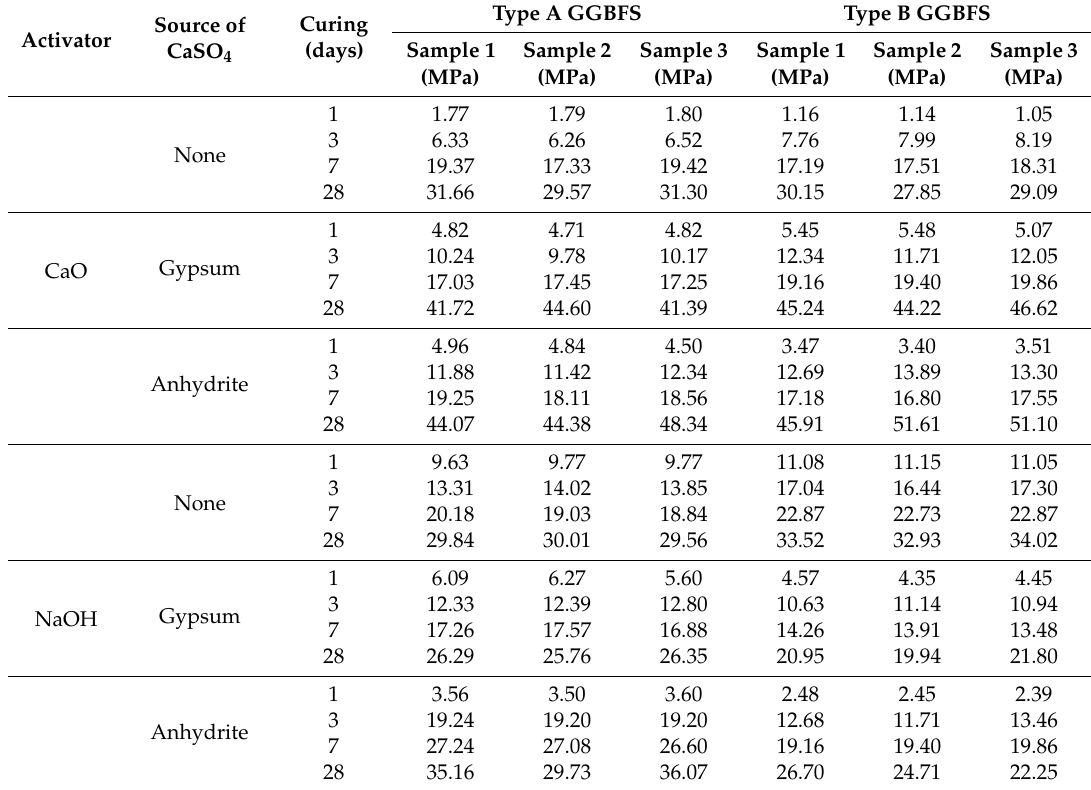
Table A1. Compressive strength of all 144 samples.